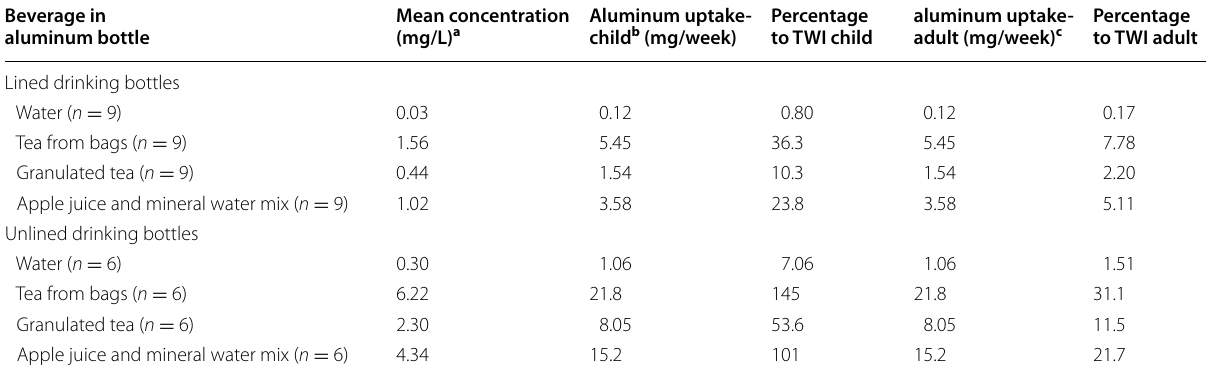
a The results shown here are the arithmetic means of the results from three repetitions of experiments on bottles from all five manufacturers b